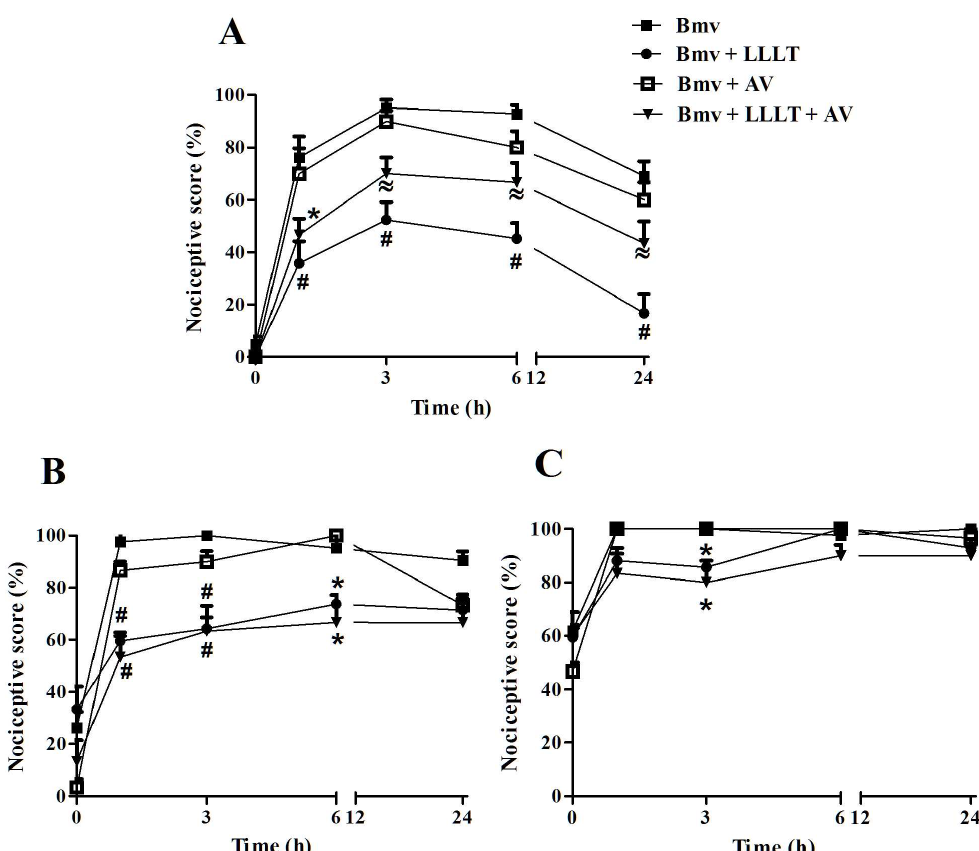
Fig 1. Effect of photobiomodulation on mechanical allodynia (A) or hyperalgesia (B and C) of mice. Animals were injected intraplantar with Bmv (1 μ g; & ) and after 30 min and 3 h were treated with LLL at 685 nm (Bmv + LLLT; ● ) or a combination of laser and antivenom (Bmv + LLLT + AV; ▼ ). Allodyniawas measuredby the mechanical response to tactile stimulation assessed by a von Frey filament of 0.407 g (3.61 filament; A). Hyperalgesia was measured by the mechanical response to nociceptive stimulation assessed by von Frey filaments of 0.692 g (3.84 filament; B) and 1.202 g (4.08 filament; C). Pain threshold was determinedbefore (baselinevalues, time 0) and 1, 3, 6, 12 and 24 h after BmV injection. Animals injected only with Bmv or with a combination of Bmv+AV ( □ ) were submitted to the same protocol. Each point represents the mean ± SEM of five to seven animals per group. ( * p < 0.05, (cid:25) p < 0.01 or #p < 0.001 vs Bmv group are